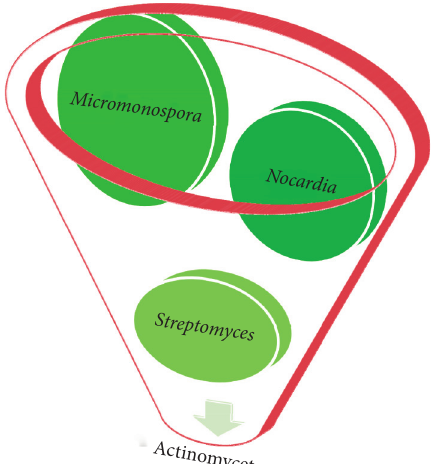
Figure 2: Graphical representation of different actinomycetes isolated. The graph represents the volumewise identification of actinomycetes species where the larger circle ( Micromonospora ) represents the higher identification in the sample followed by the medium circle ( Nocardia ) and small circle ( Streptomyces ).